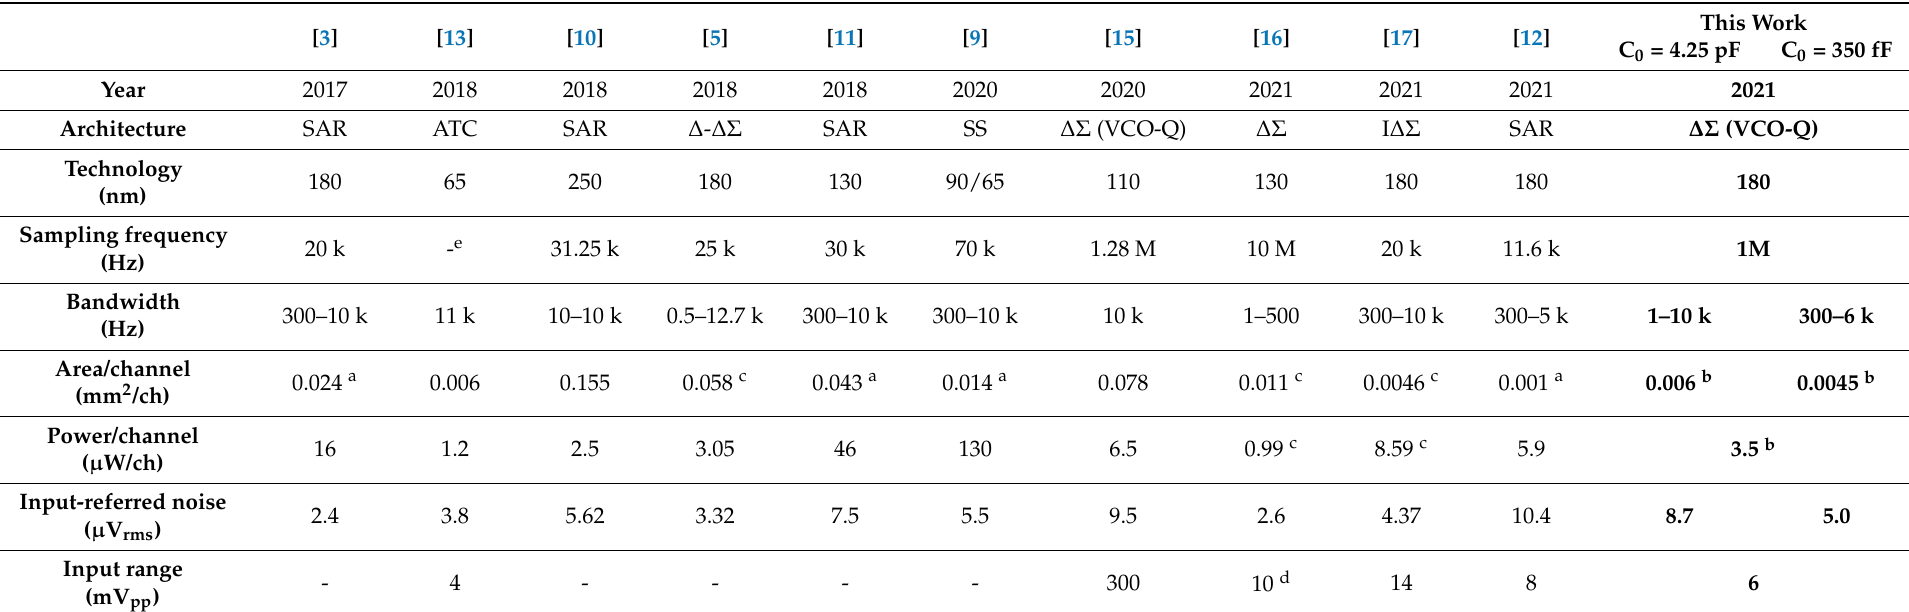
Table 1. Performance summary and comparison with